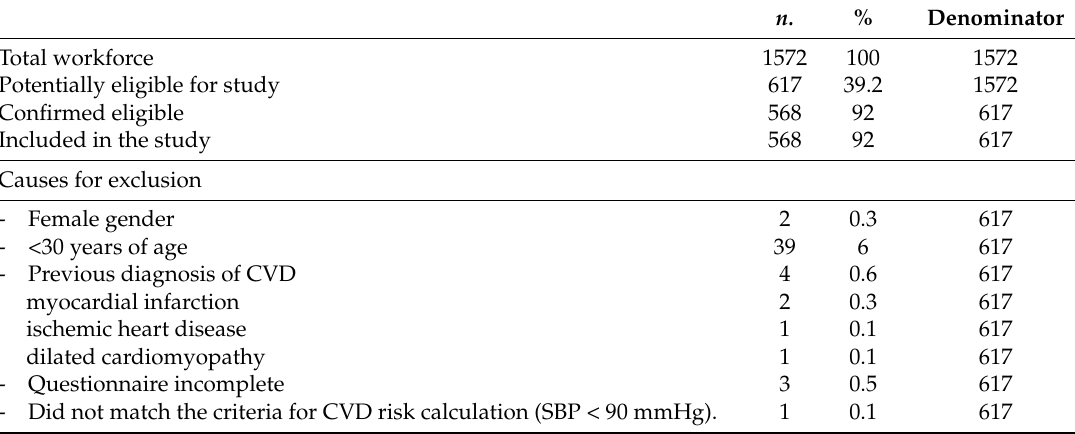
Table 1. Flow chart from eligible subjects to analyzed study